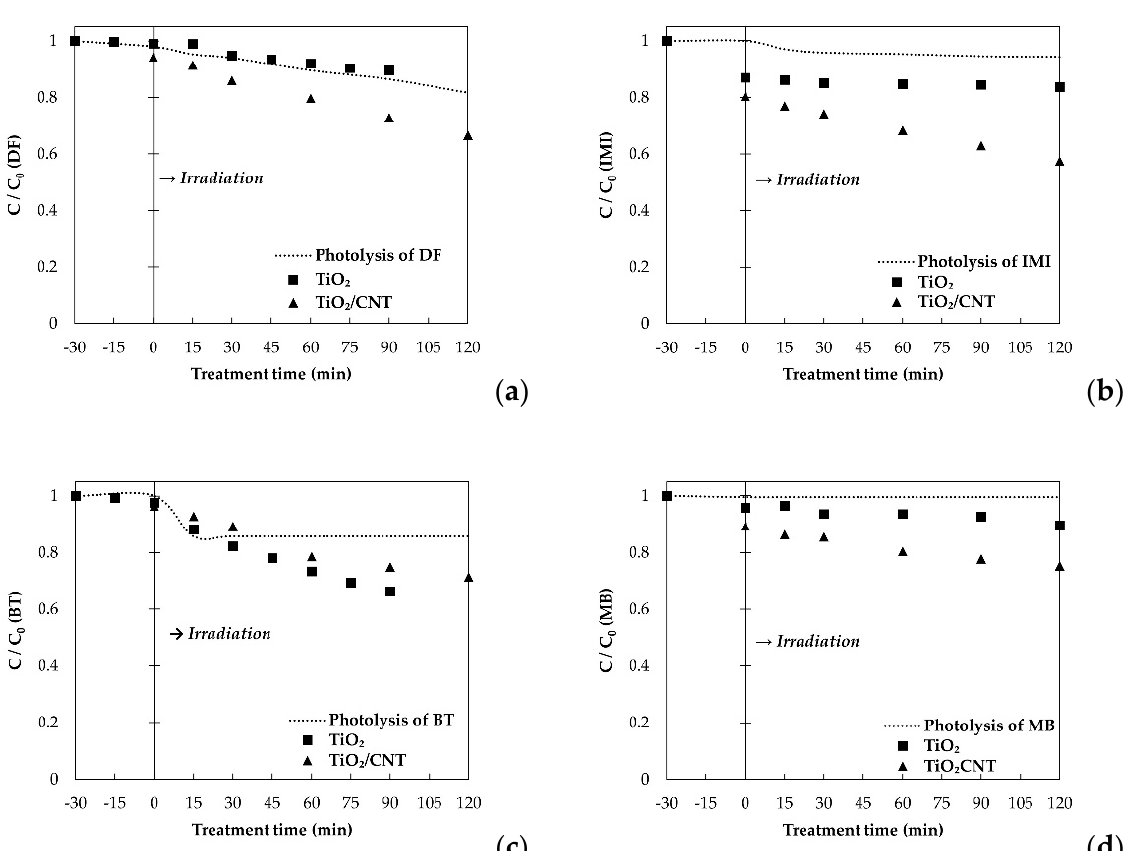
Figure 4. Experimental results of photolytic and photocatalytic degradation on TiO 2 and TiO 2 /CNT of: ( a ) diclofenac (DF), ( b ) imidacloprid (IMI), ( c ) 1H-benzotriazole (BT), ( d ) methylene blue (MB). Presented results are obtained during the dark and irradiated experiments.